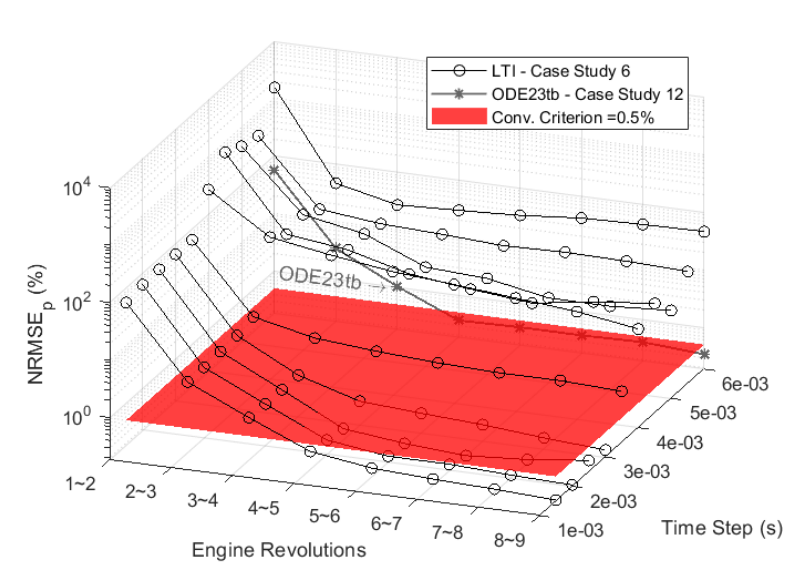
Figure 6. Case studies 6 and 12 results: NRMSE p versus time step for case study 6 (variable inertia- speed approach, most complex friction submodel and Linear Time-Invariant (LTI) scheme); NRMSE p for case study 12 (variable inertia-speed approach, most complex friction submodel and ODE23tb